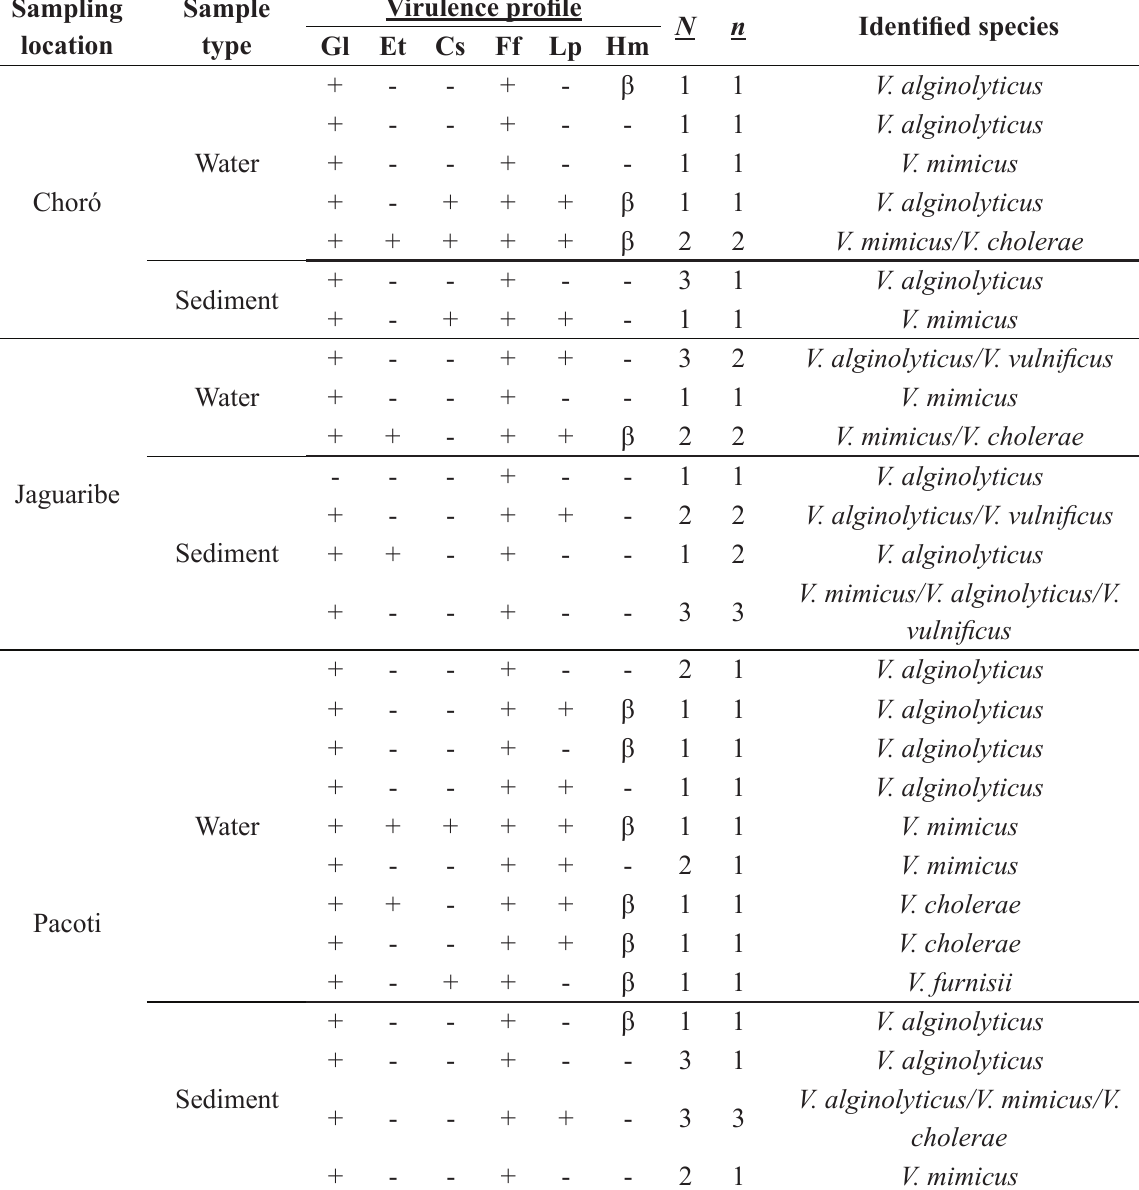
Virulence factor profile shown by potentially pathogenic to man Vibrio spp. in water and sediment samples from the estuaries of Pacoti, Choró, Pirangi and Jaguaribe rivers